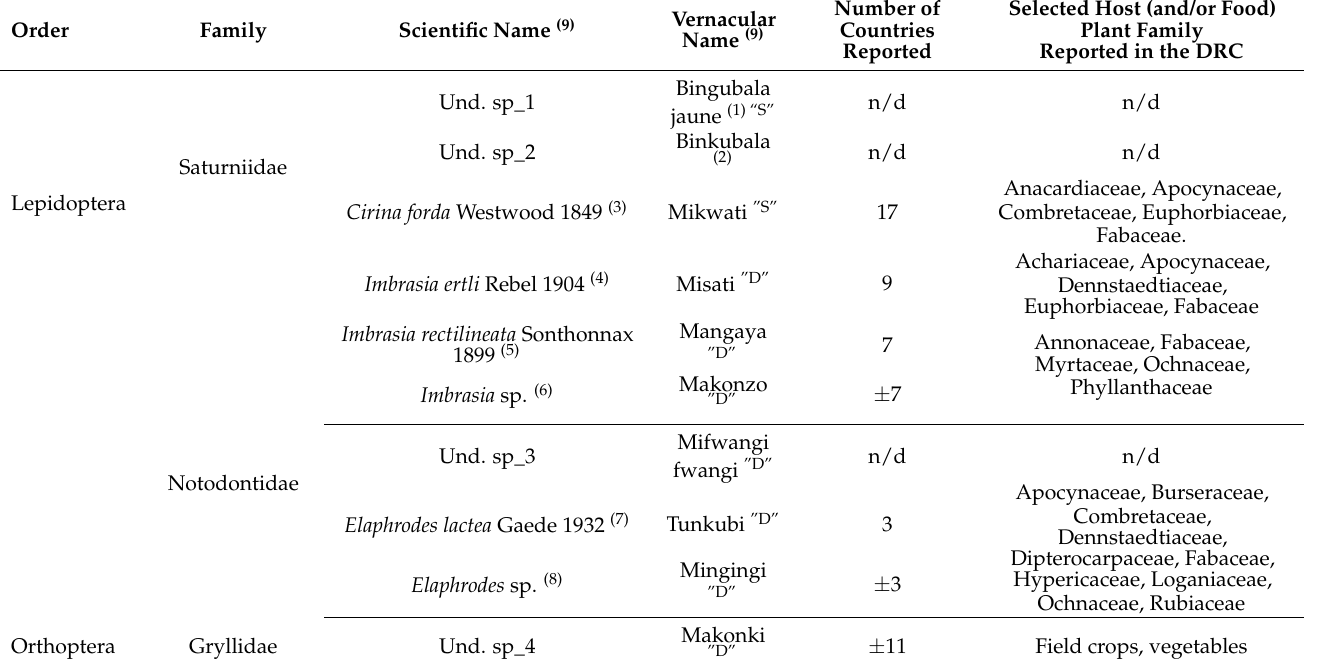
Table 1. Nomenclature of sampled edible insect species—[n/d] stands for “no